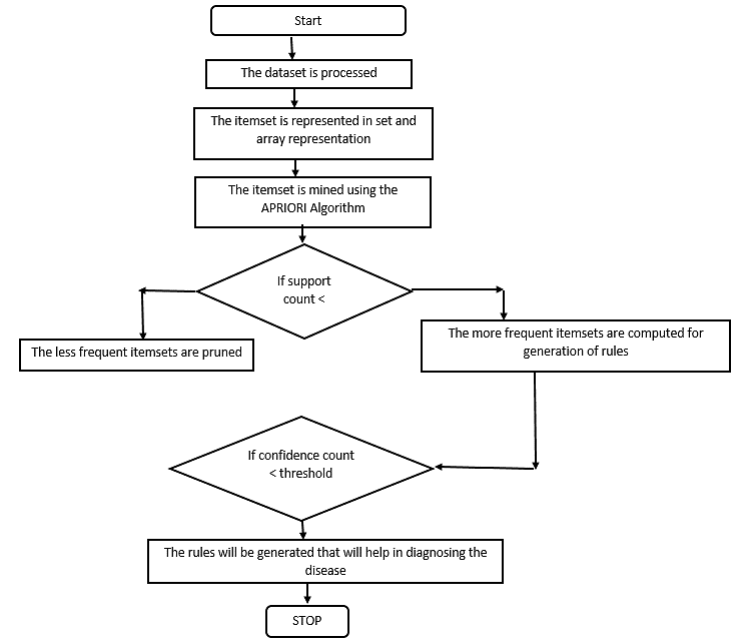
Figure 5. Flowchart of the methodology.